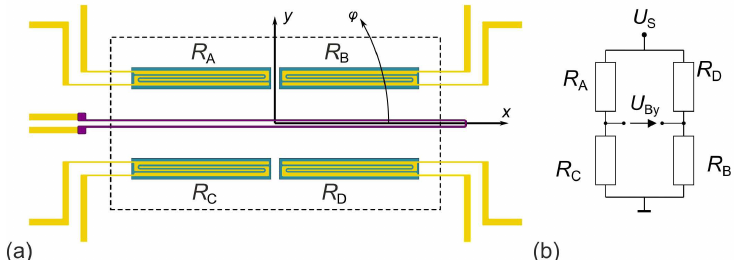
Figure 1. Membrane region of a simple extension of the calorimetric flow transducer layout. A slim heating resistor (purple trace) separates the rectangular membrane area (dashed rectangle) into upper and a lower region, each bearing a pair of membrane thermistors made of aGe (dark blue rectangles) with interdigitated contacts (yellow regions). This particular design ( a ) and Wheatstone bridge configuration ( b ) aims at pronounced sensitivity for flows along the y -coordinate.